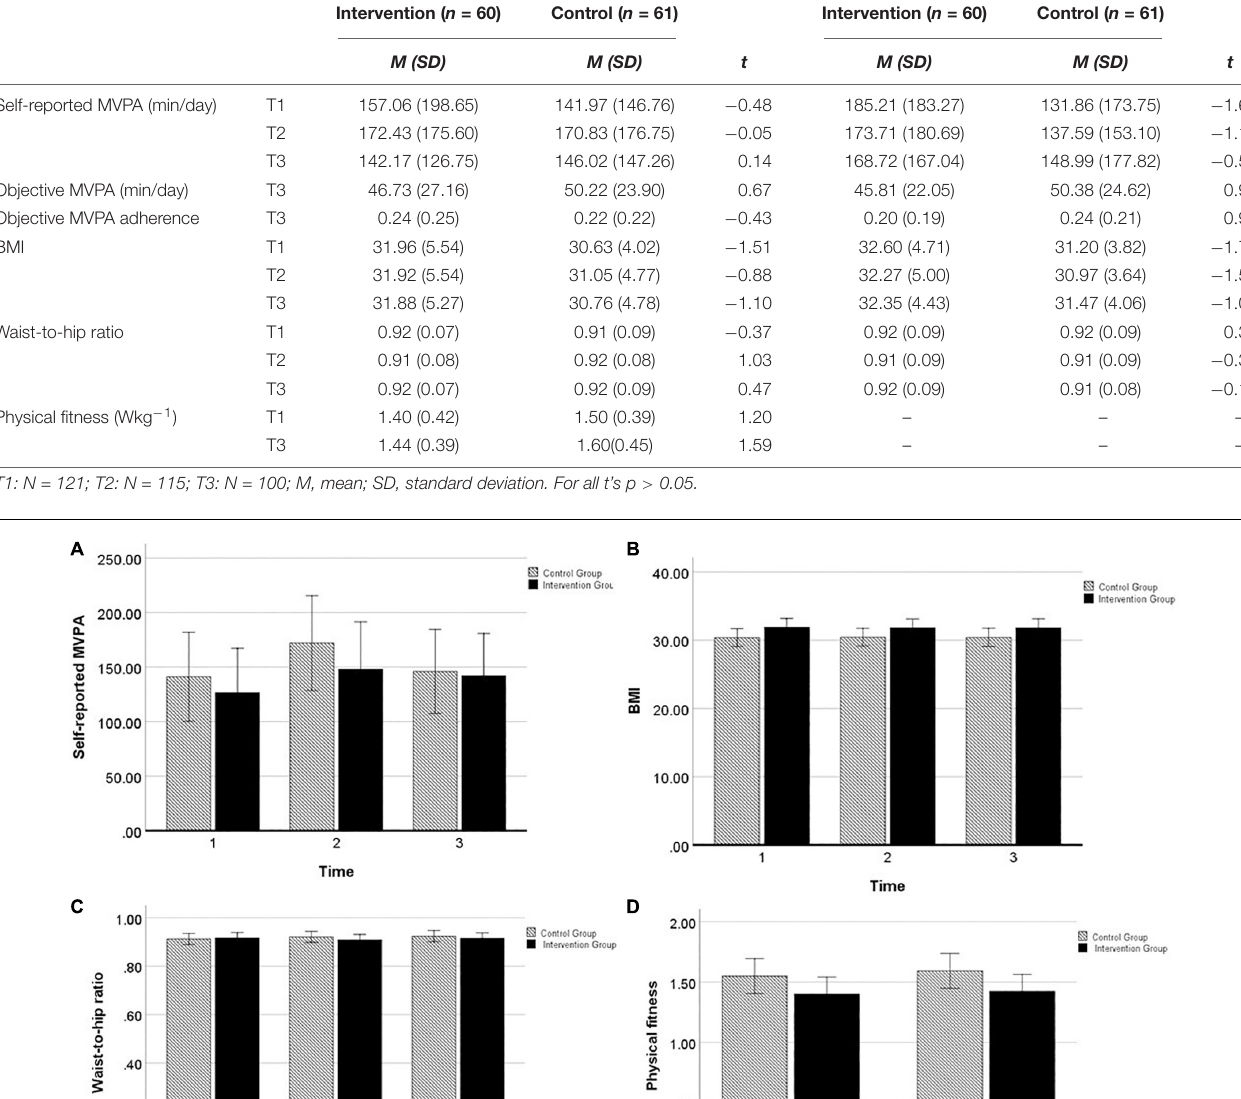
= 0.004], p = 0.02], or time by p